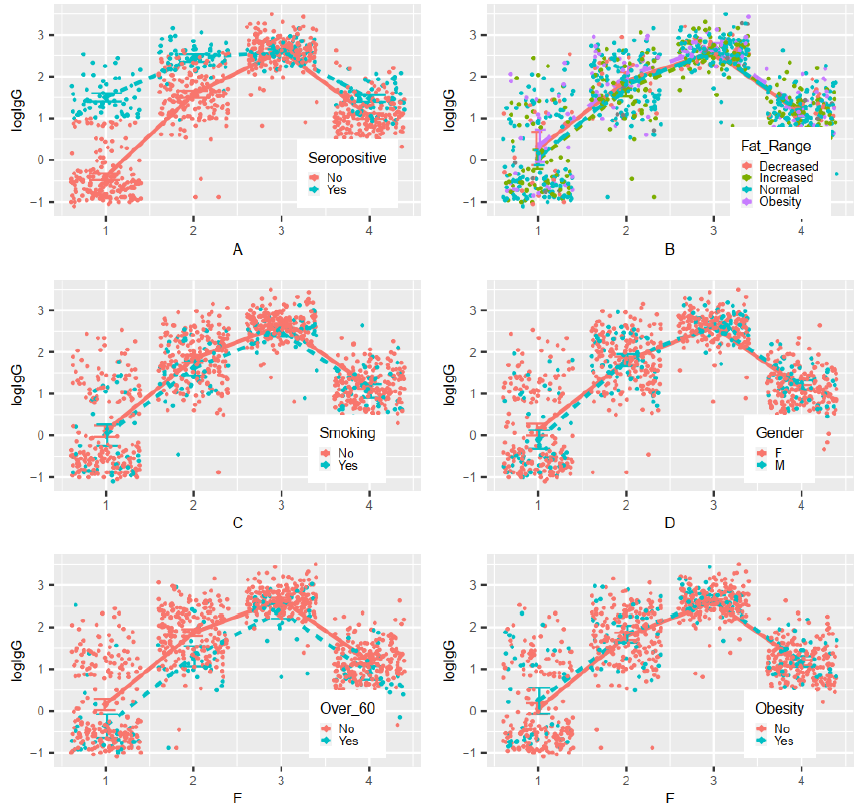
Figure 4. Changes in IgG titer over time depending on selected parameters (ANOVA results) before the first dose (1), before the second dose (2), early FU 14 days after receiving the second dose (3), late FU eight months after full inoculation (4): A — COVID-19 disease before first vaccination: significant time and group effect and interaction of the time and group p < 0.05; B—fat range: significant time effect p < 0.05; C—smoking: significant time effect p < 0.05; D—gender: significant time effect and interaction of time and group p < 0.05; E—age over 60: significant time and group effects p < 0.05; F—obesity: significant time effect p < 0.05. Abbreviations: